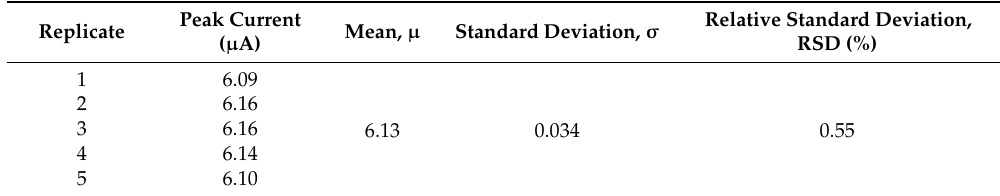
Table 2. Reproducibility of 60 ng/mL of CFP10 antigen.